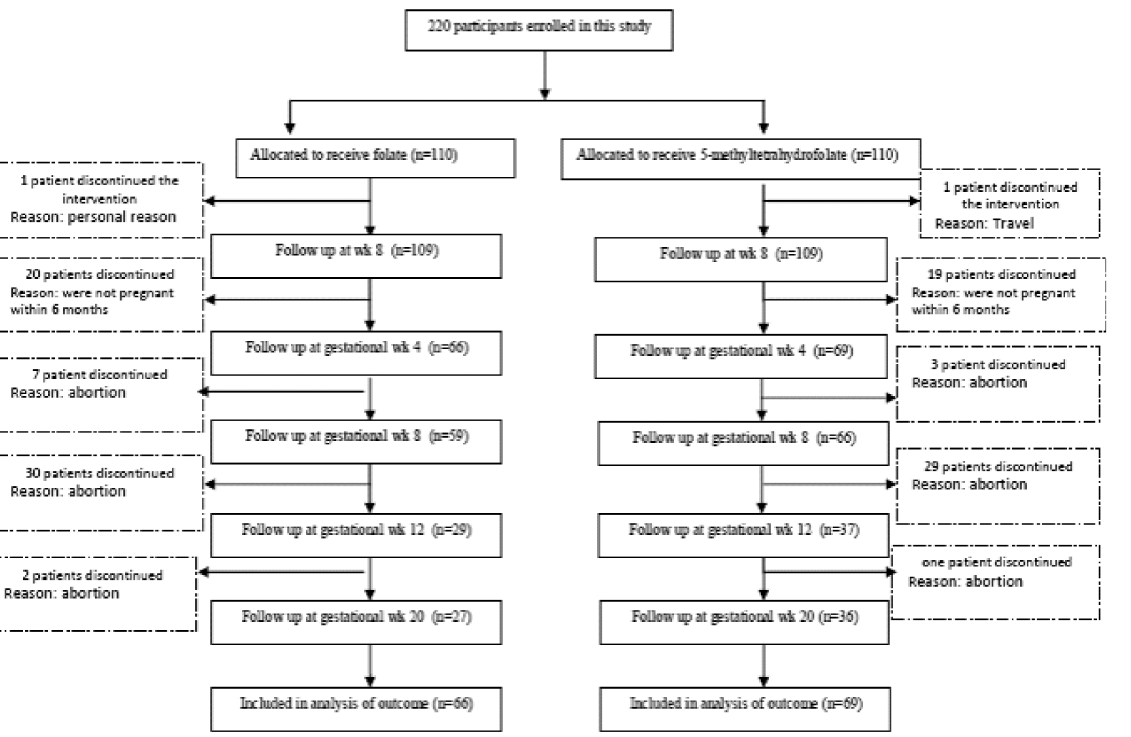
Fig 1. CONSORT Flow Diagram of Trial